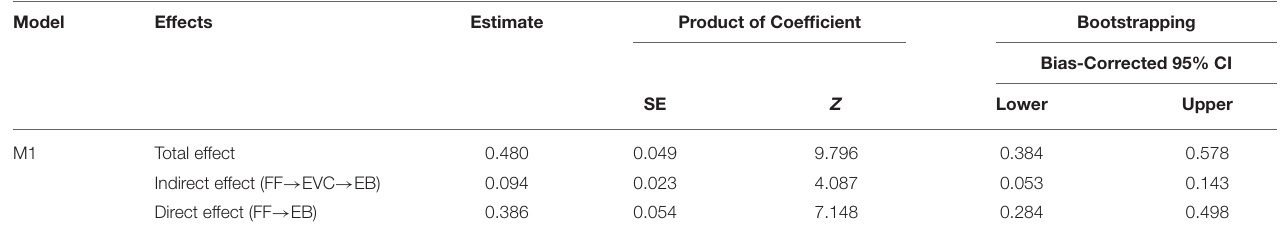
TABLE 4 | Bootstrap analysis of the significance test of the mediating effect.